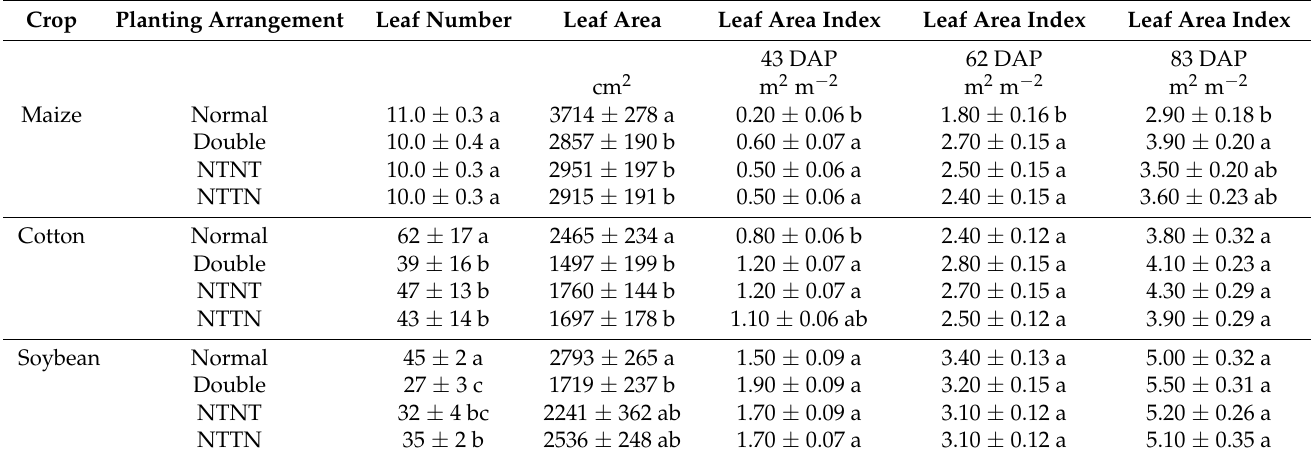
Table 3. Leaf number, leaf area, and leaf area index measurements for maize, cotton, and soybean for each planting arrangement. NTNT: a sequential arrangement of normal and tripled densities (each in every other row), and NTTN: normal-tripled-tripled-normal. Means and standard error of the means followed by a different letter indicate significant differences at p <